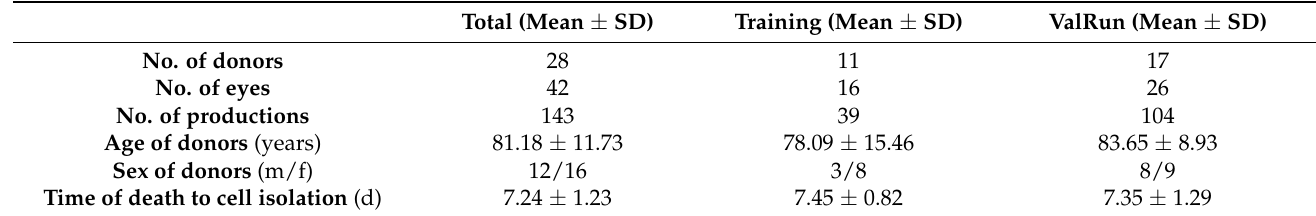
Table 3. Donor characteristics of eyes used for training and validation. m = male; f =